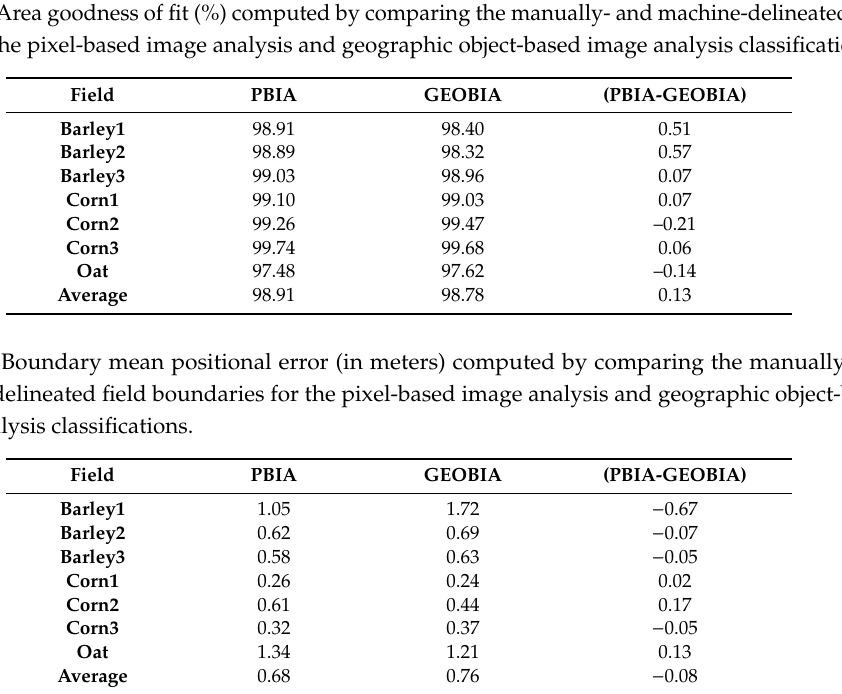
Table 13. Boundary mean positional error (in meters) computed by comparing the manually- and machine-delineated field boundaries for the pixel-based image analysis and geographic object-based image analysis classifications.